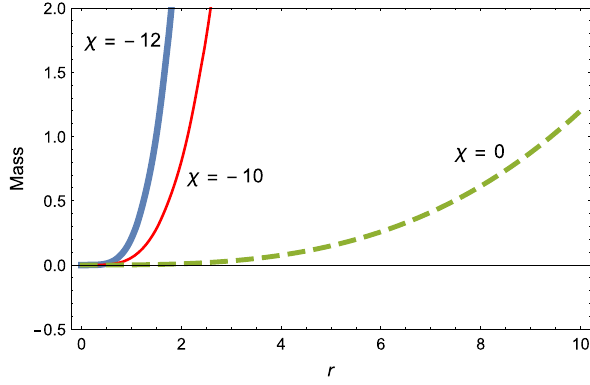
Fig. 4 Weak energy condition versus radial value r